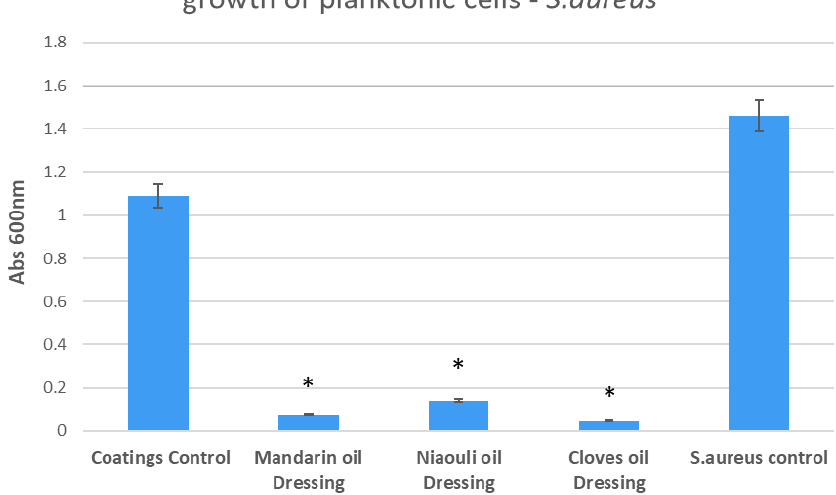
Figure 9. Growth of planktonic cultures of S. aureus in the presence of wound dressings coated with EOs functionalized silver nanoparticles (NPs). Coatings Control—dressing modified with silver NPs, Mandarin oil Dressing — dressing modified with silver NPs and mandarin EO, Niaouli oil Dressing — dressing modified with silver NPs and niaouli EO, Clove oil Dressing – dressing modified with silver NPs and clove EO. *P < 0.05 (control coatings vs. NPs and EOs coated samples for each strain). In the case of E. coli , the most significant growth inhibition was achieved in the presence of mandarin EO functionalized silver NPs, with the values obtained for niaouli and clove EOs being similar to those obtained for the plain silver NPs (Figure 10).